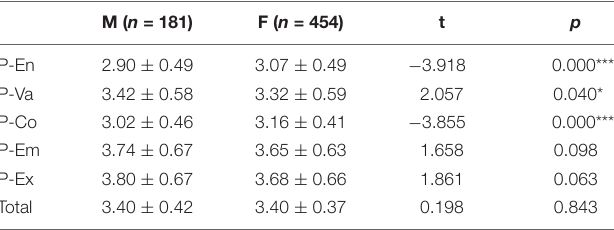
TABLE 2 | Analysis of gender differences in medical students’ professional identity.